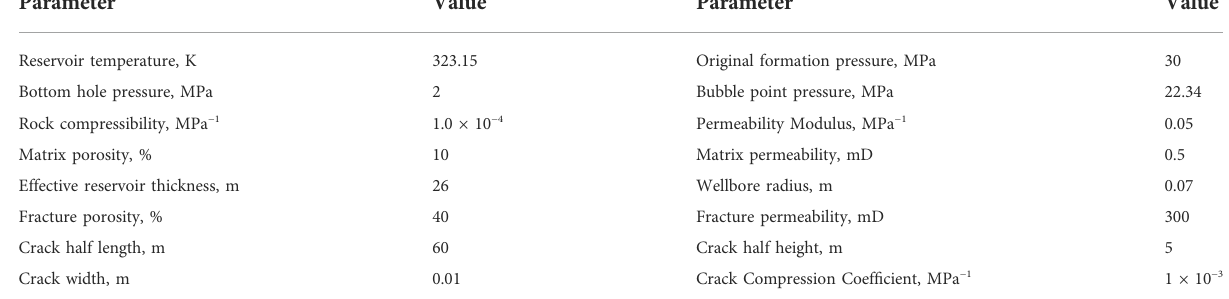
TABLE 1 Input parameters of reservoir, fl uid and fracture used for model veri fi cation. Parameter Value Parameter Value